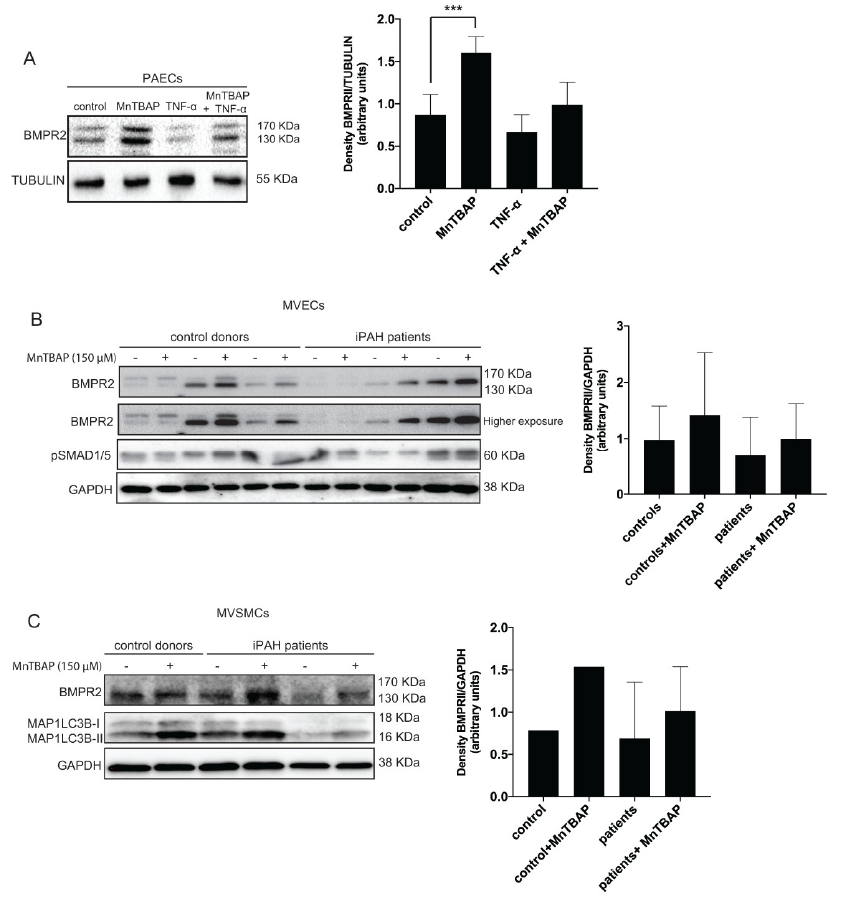
Figure 3. MnTBAP restores the levels of BMPR2 in pulmonary microvascular endothelial cells (MVECs) and microvascular smooth muscle cells (MVSMCs) isolated from idiopathic pulmonary arterial hypertension (iPAH) patients. ( A ) hPAECs were treated with MnTBAP (150 µM) for 16 h and TNF-α (10 ng/mL) for 2 h. Left panel: BMPR2 protein expression was analyzed by western blot. Tubulin is used as a loading control. Representative results of at least 3 independent experiments are shown. Right panel: Quantification of BMPR2 protein levels. ( B and C ) Pulmonary MVECs and MVSMCs isolated from iPAH patients were treated with MnTBAP (150 µM) for 24 h. Left panel: BMPR2, pSMAD1/5 and MAP1LC3B-II protein expression was analyzed by western blot. GAPDH is used as a loading control. Representative results of at least 3 independent experiments are shown. Right panel: Quantification of BMPR2 protein levels. Data presented as mean ± SD. *** p < 0.001.